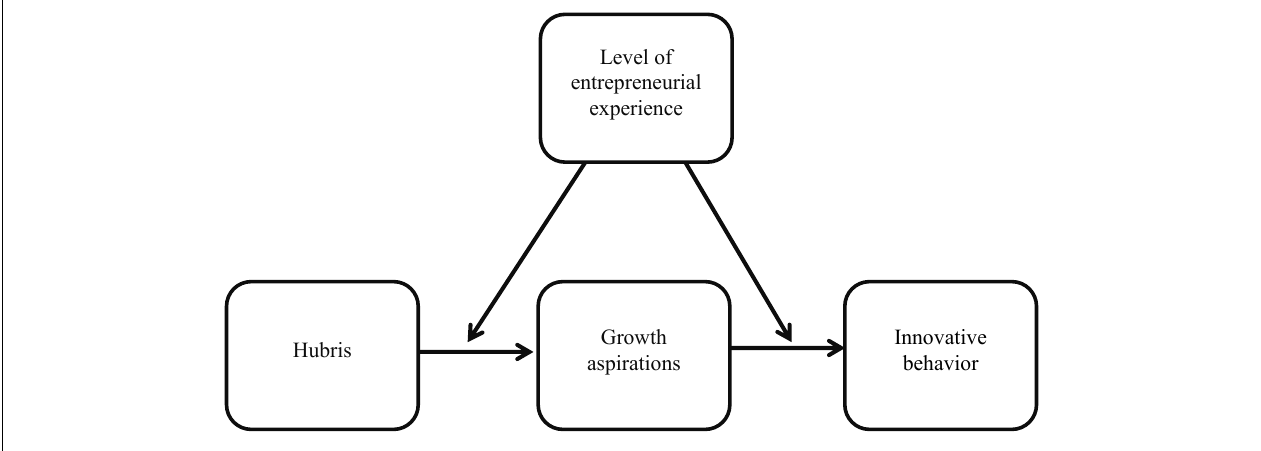
FIGURE 1 | A moderated mediation model of the influence of hubris on innovations.